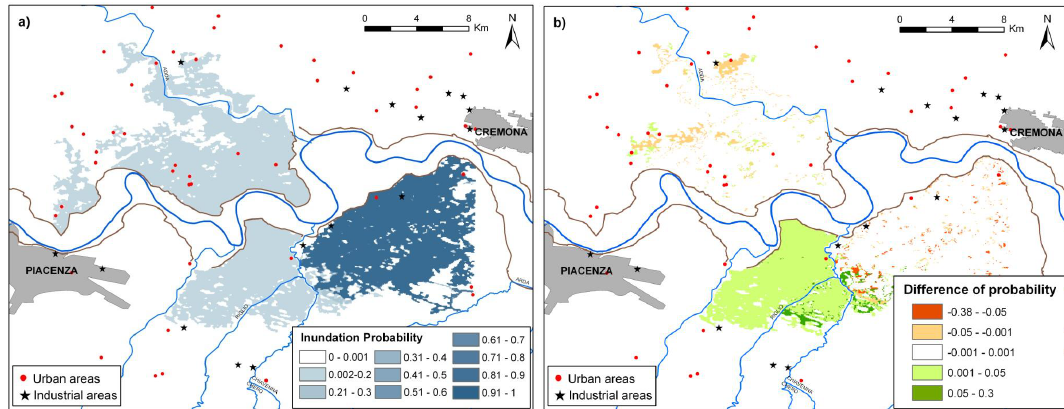
Fig. 8. (a) : probabilistic flood hazard map for the Tr200 event adopting the MedianC subset; (b) : difference in probability of flooding adopting RandomC and MedianC subsets.